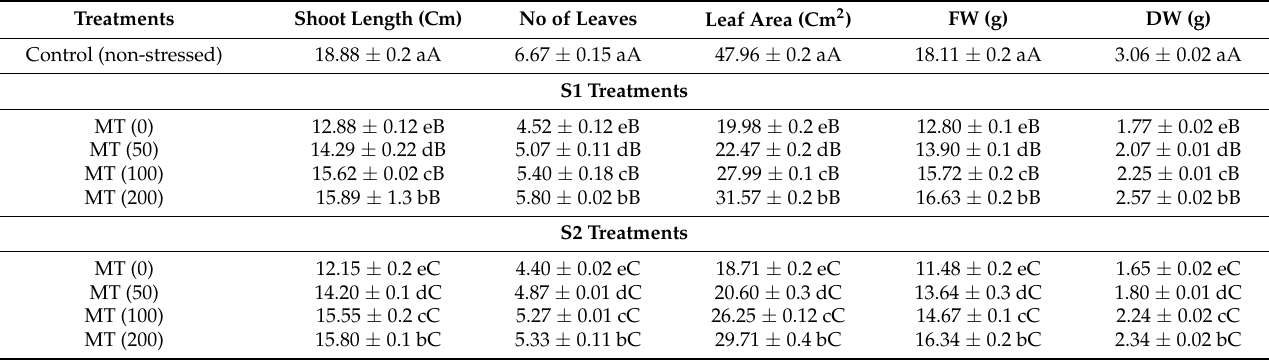
Table 1. The effects of exogenous melatonin application on growth parameters of R. asiaticus under salinity